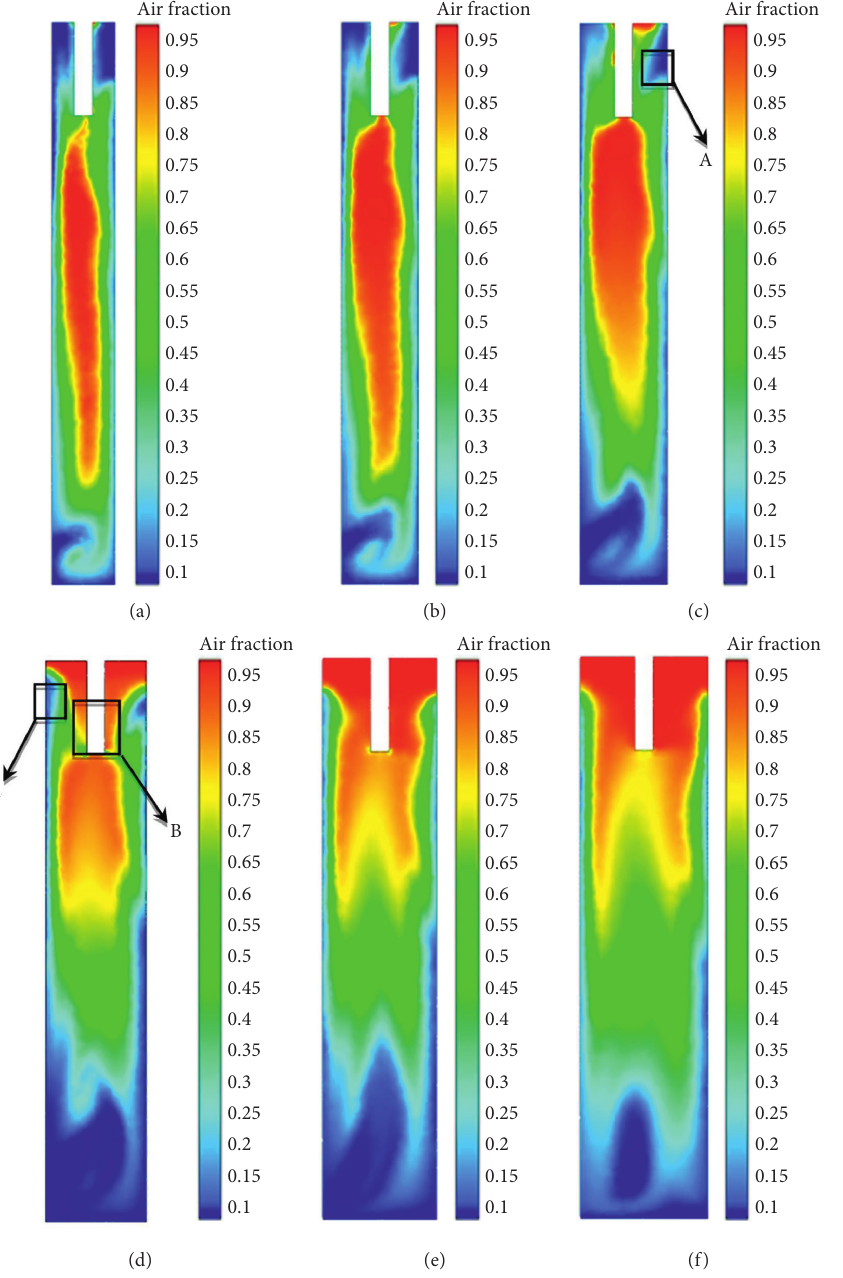
� 10 mm. (b) d � 12 mm. (c) sep sep